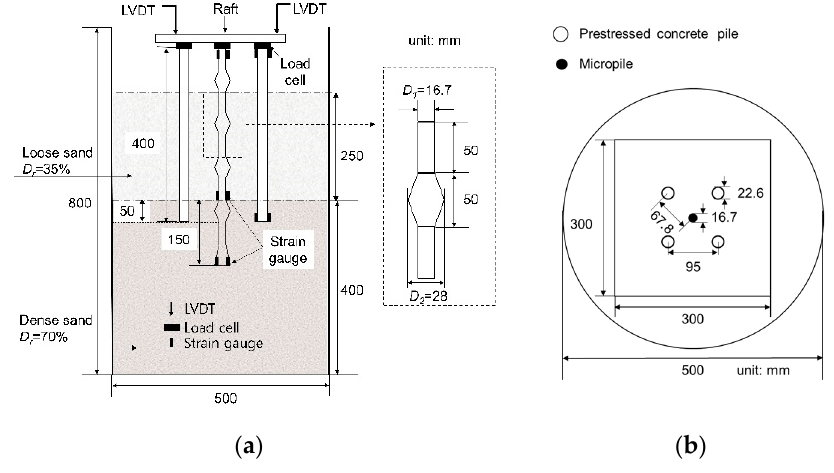
Figure 2. Schematic of experimental set-up. ( a ) Elevation view; ( b ) top view. Table 1. Size and properties of prototype and model piles.